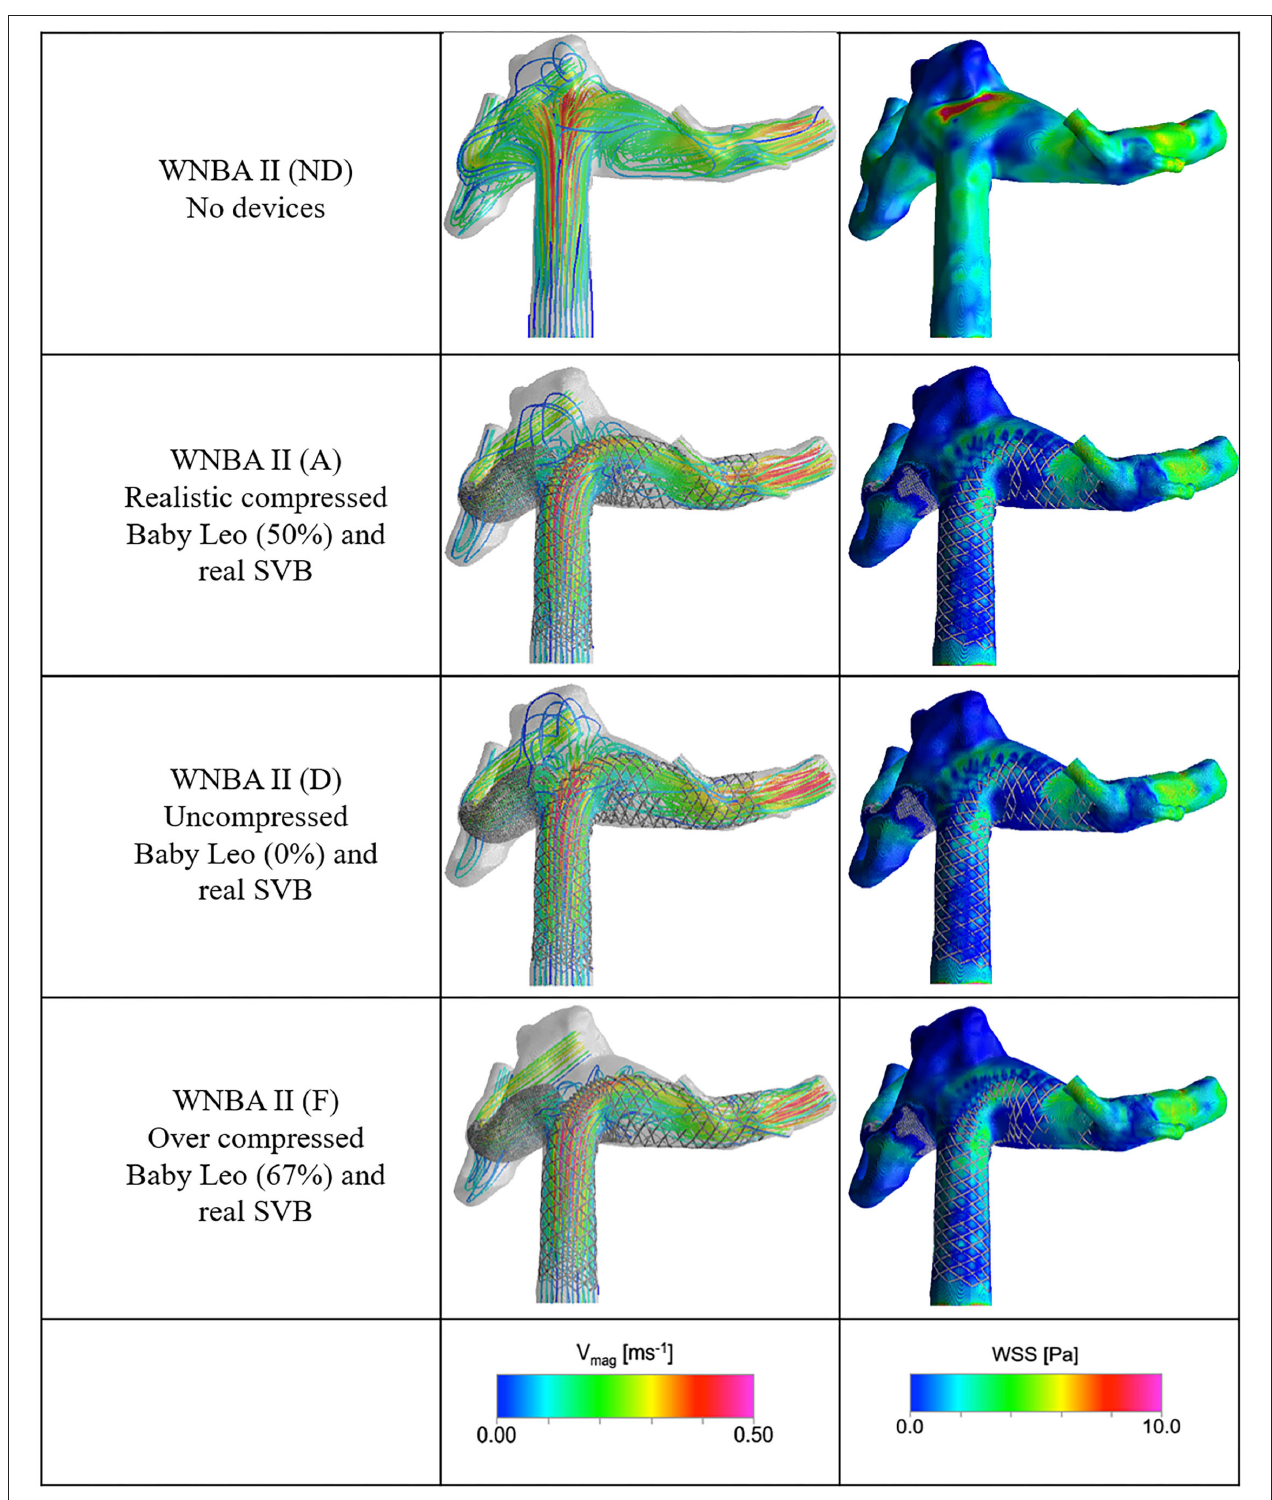
FIGURE 7 | Velocity streamlines and WSS distributions for the No Device (ND) and selected device configurations (cases A, D, and F) for the WNBA II geometry.